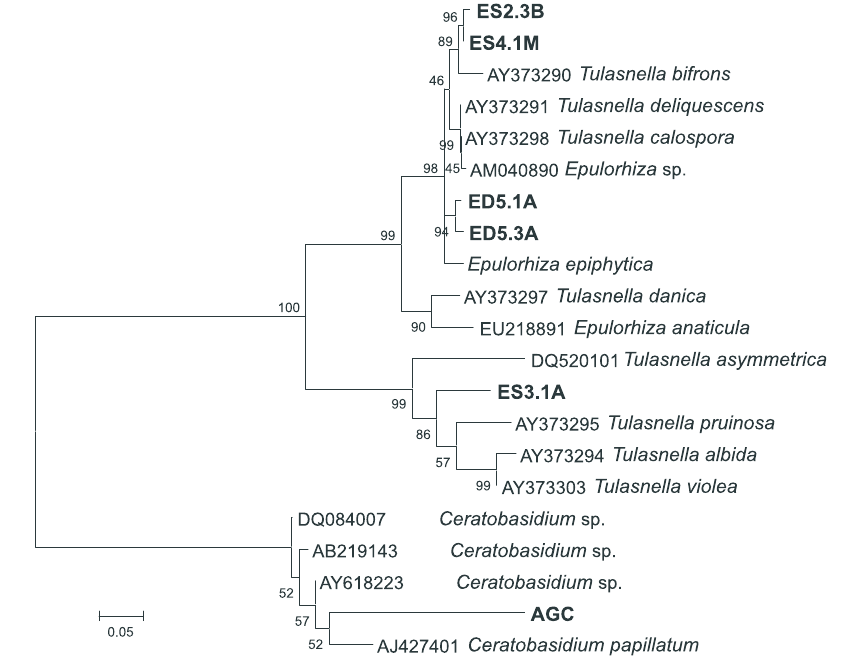
Figure 4. Clustering of Rhizoctonia -like fungi isolates and Tulasnella spp., Epulorhiza spp., and Ceratobasidium spp. fungi based on rDNA sequences of the ITS region using the Neighbor-Joining method and Kimura 2-parameter algorithm, based on 5000 bootstrap replicates, excluding gaps and missing data. Codes highlighted in the clusters correspond to the isolates presented in Table